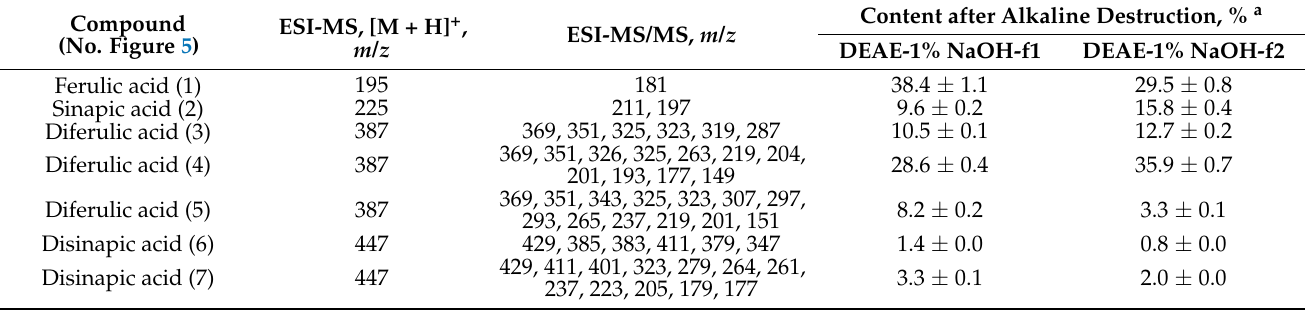
Table 7. Characterization and content of degradation products released after alkaline destruction